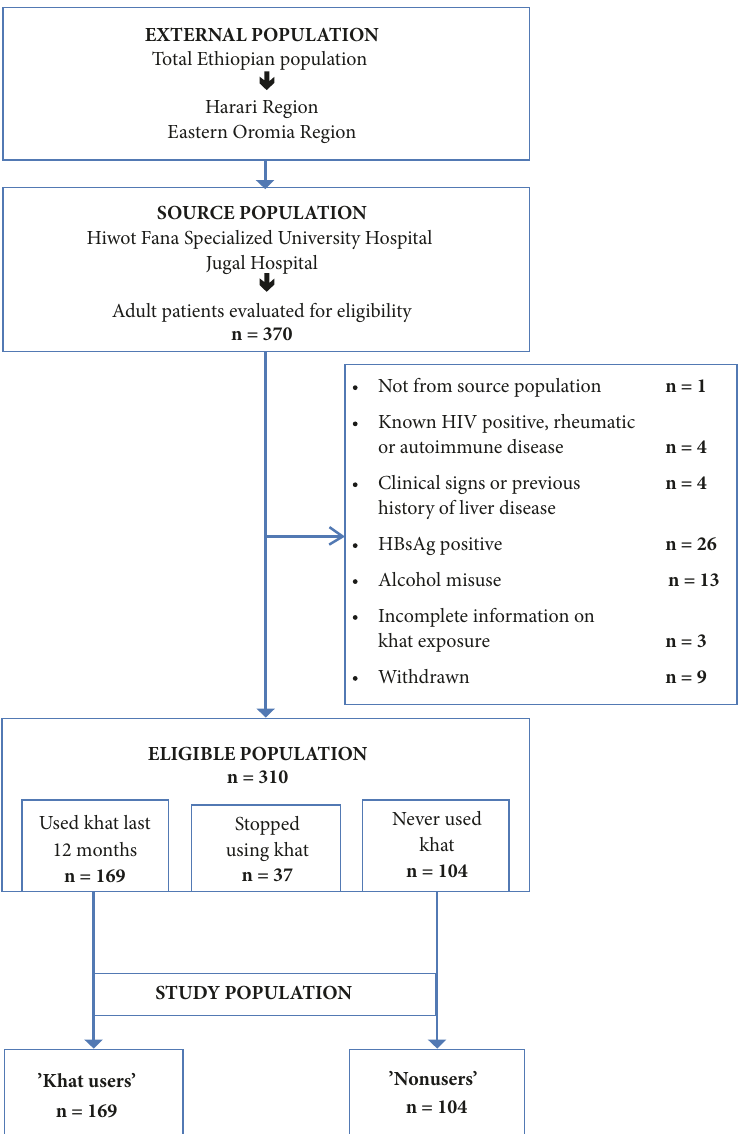
Figure 2: Study flow diagram illustrating the selection of the study subjects. Abbreviations: HBsAg : hepatitis B surface antigen; HIV : human immunodeficiency